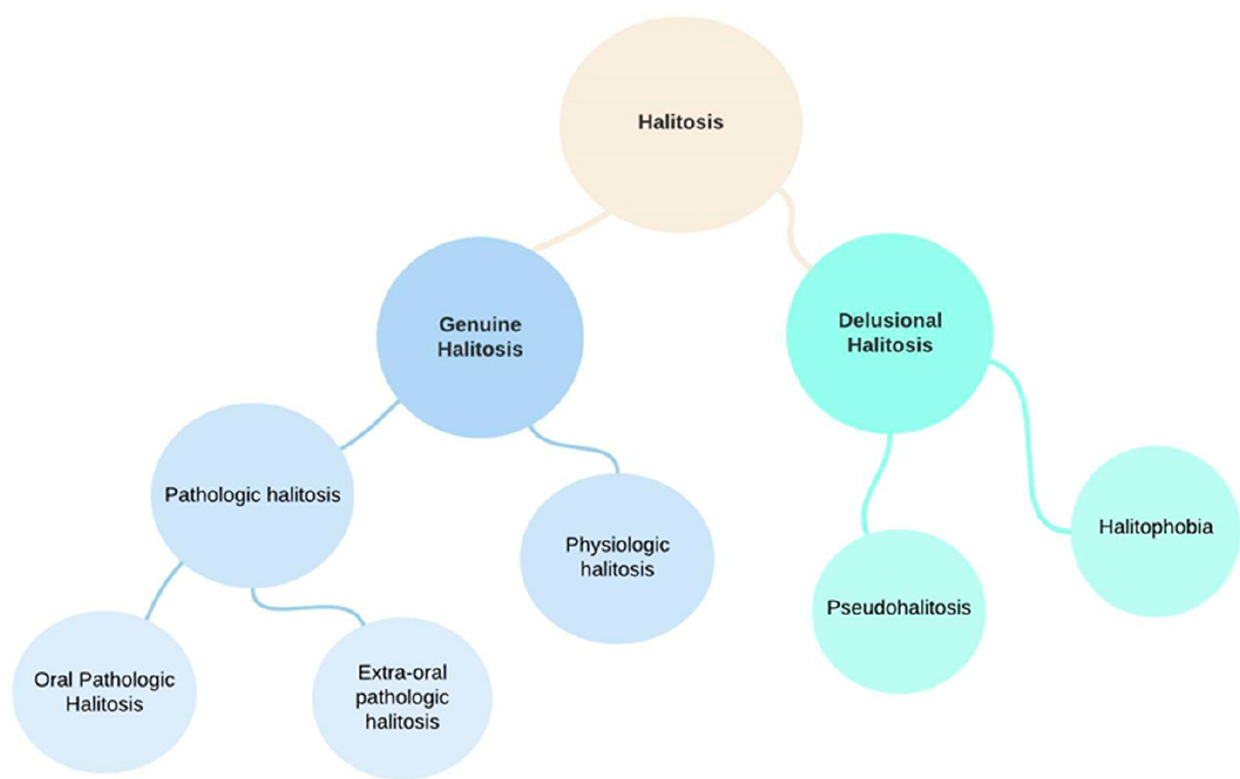
Figure 2. Current classification of halitosis.